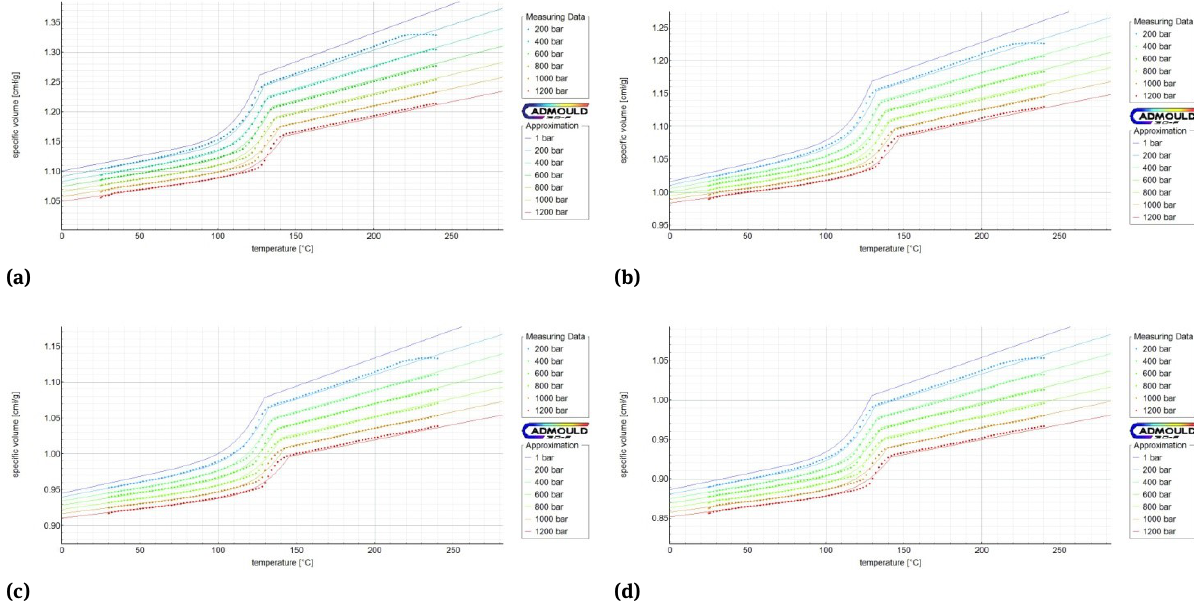
Figure 4: Obtained p-v-T characteristic: a) raw PP RP2380, b) PP RP2380 filled with 10% of chalk, c) PP RP2380 filled with 20% of chalk, d) PP RP2380 filled with 30% of chalk; dots – measuring data, lines – numerical approximation with Renner model using SimFit software